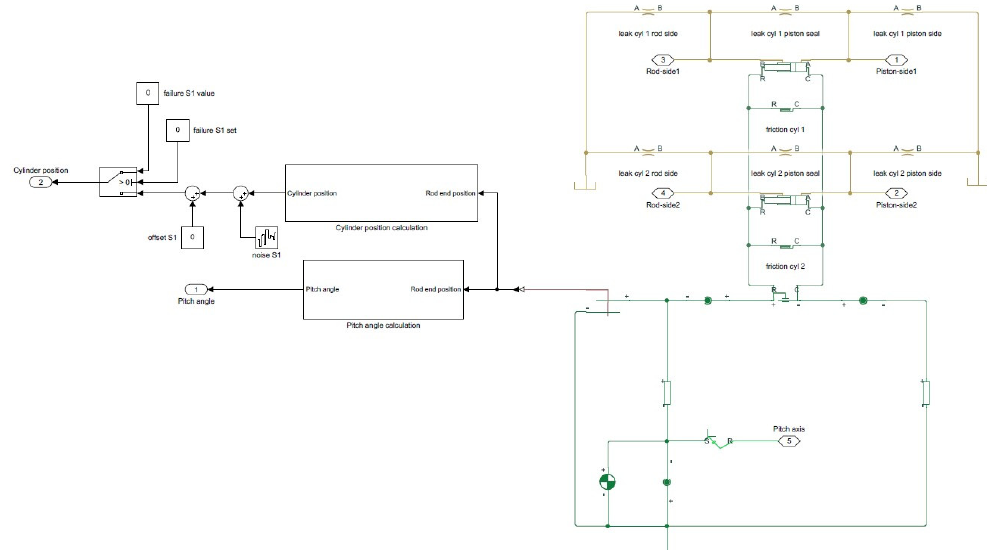
Figure 7. Individual blade pitching mechanism model.